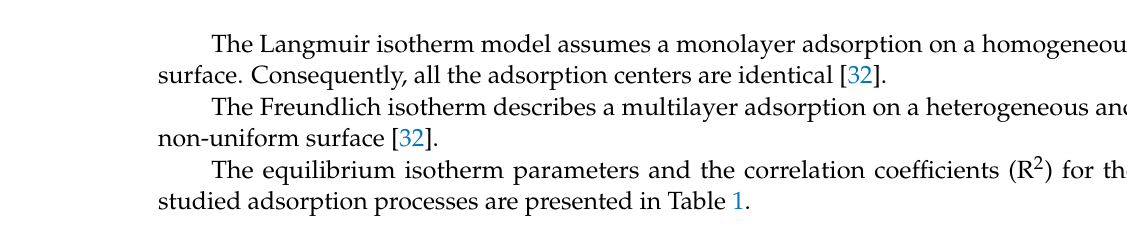
Table 1. Langmuir and Freundlich parameters for the dyes’ adsorption onto CoFe 2 O 4 and CoFe 2 O 4 –Chit from single- component